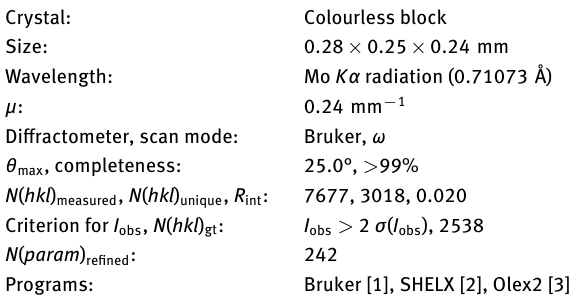
Table 1 contains crystallographic data and Table 2 contains the list of the atoms including atomic coordinates and dis- placement parameters.